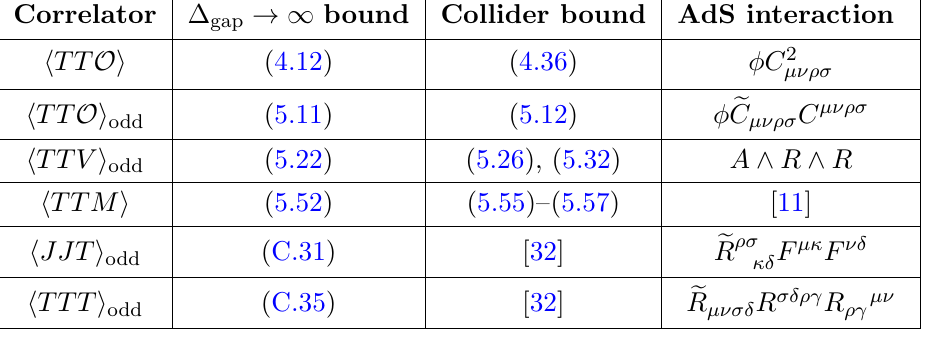
Table 1 . Summary of